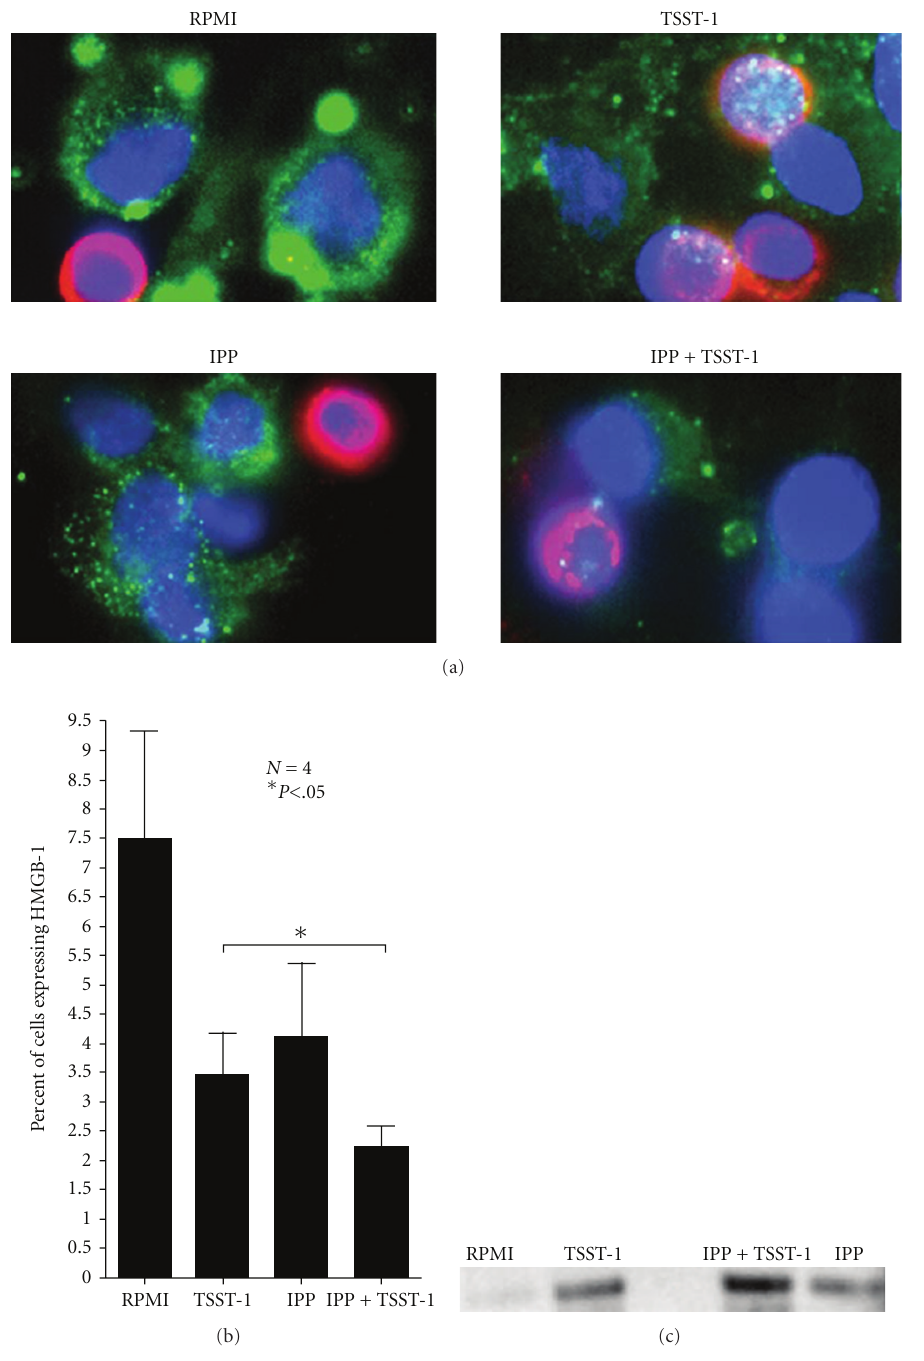
Figure 4: Change in cell surface expressed HMGB-1 (amphoterin) on adherent monocytes in PBMC following IPP and TSST-1 treatment. (a) Fluorescent microscopy of surface-expressed HMGB-1 in PBMCs. HMGB-1 is shown in green, T cells in red, and nucleus in blue. Top left panel—Resting PBMC cultured on cover slips for 48 hours were stained for surface expressed HMGB-1. Top right panel—Surface expression of HMGB-1 after 24 hour culturing in growth medium followed by 24 hour TSST-1 treatment. Bottom left panel—Surface expression of HMGB-1 48 hours after IPP treatment. (Bottom right panel) Surface expression of PBMC that had been treated overnight with IPP and subsequently treated with TSST-1 for 24 hour. (b) Bar graph of the flow cytometry analysis quantifying the release of HMGB-1 from the cell surface ( N = 4; error bars represent SD). Statistic shown compares IPP + TSST-1 versus TSST-1 alone ( P < . 05, paired Student’s t -test). (c) Western blot analysis of secreted HMGB-1 in cultured